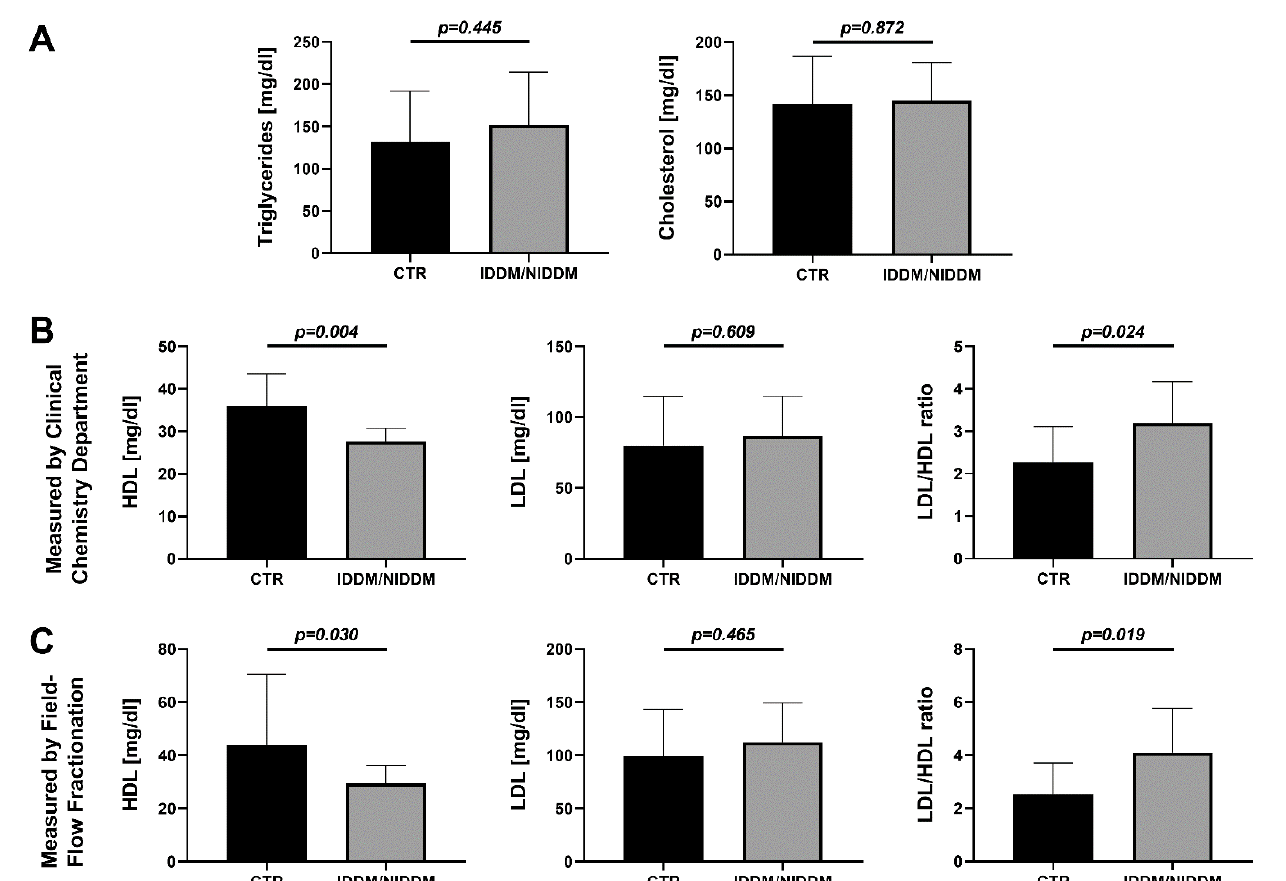
Figure 4. Serum markers of lipometabolism. ( A ) No obvious increase in triglycerides or total cholesterol in the IDDM/NIDDM versus CTR group. ( B ) (measurement by Clinical Chemistry Department) and ( C ) (measurement by Field-Flow Fractionation). Significant lower concentration of HDL-cholesterol together with a slightly higher concentration of LDL-cholesterol resulting in a significant raise of LDL/HDL ratio in the IDDM/NIDDM versus CTR group. Data are mean ± SD of n = 12 (CTR) and 11 (IDDM/NIDDM) ( A , B ) and n = 12 (CTR) and 10 (IDDM/NIDDM) ( C ) patients. Unpaired t -test in ( A – C ) [LDL and LDL/HDL ratio] and Mann–Whitney test in ( C ) [HDL]. CTR, control; IDDM, insulin-dependent diabetes mellitus type 2; NIDDM, non-insulin-dependent diabetes mellitus type 2.